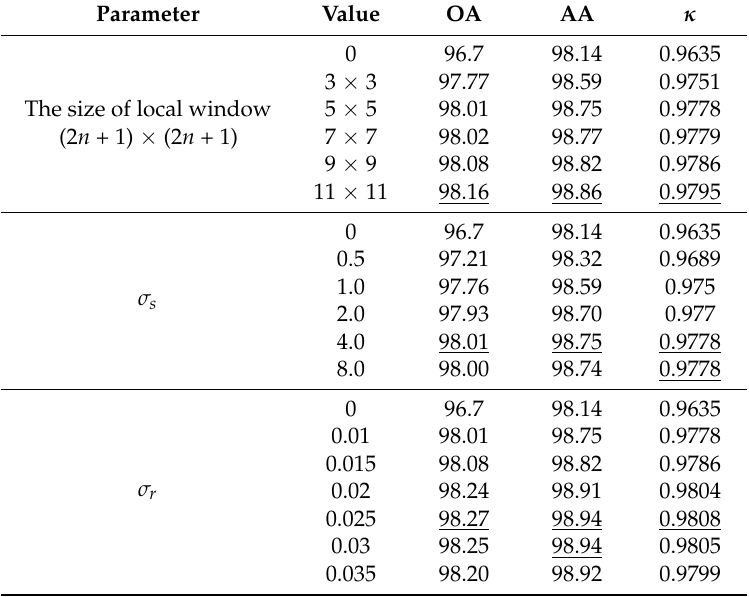
Table 7. The impact of different parameter settings on classification accuracies using the CS-GC + JBF method for the Salinas data set. The highest accuracies are indicated in underlined in each